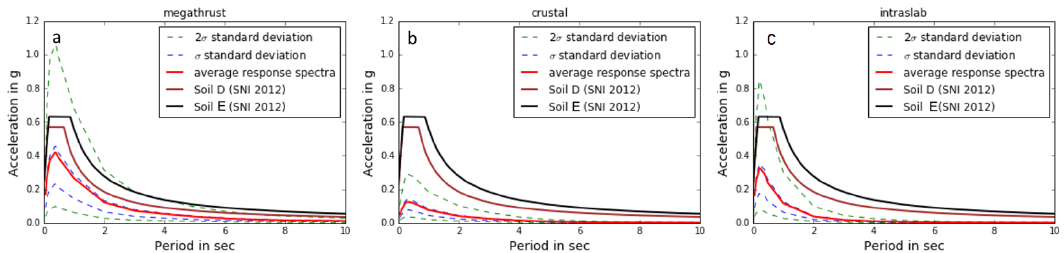
Figure 11. Design response spectra used for the 2012 Indonesian Building Code for soil sites (classes D and E are brown and black curves, respectively) in Jakarta, compared with average , 1- and 2- σ (solid red, blue dashed and green dashed, respectively) results for simulated response spectra (SRS) calculated in the Jakarta Basin for the ( a ) megathrust (GMPE:AEA2015); ( b ) crustal (GMPE: CY2014) and ( c ) intraslab (GMPE:AEA2015S)earthquake scenarios. Each curve represents the results of calculations at all sites for which V S 30 and Z 1.0 , have been estimated, as well as 1000 ground motion realizations that have sampled the aleatory variability in the respective